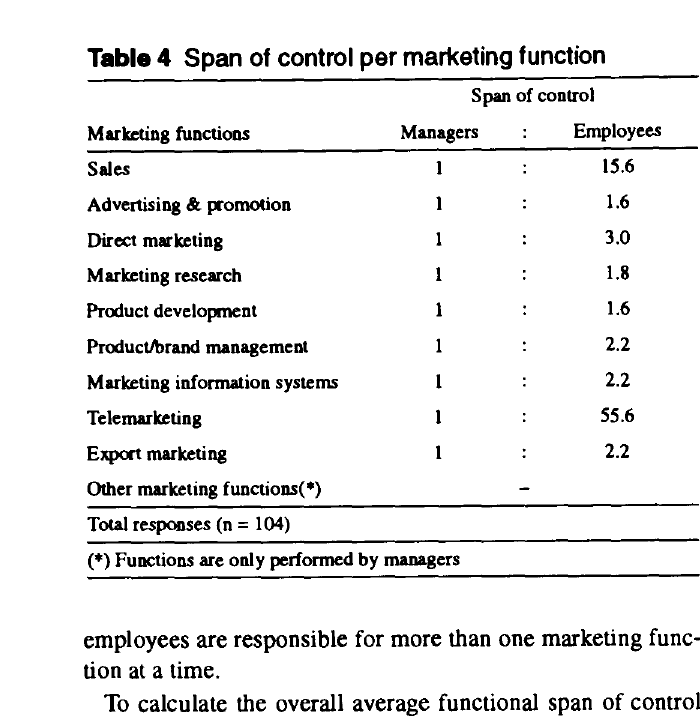
Table 4 Span of control per marketing